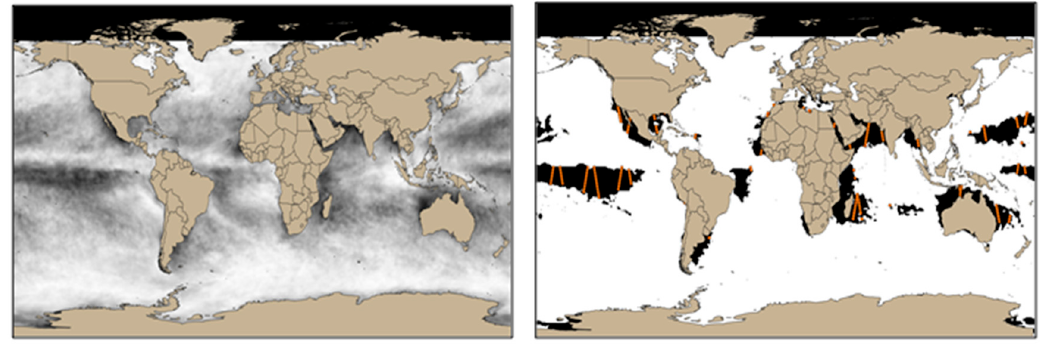
Figure 2. ( Left ) Temporal average of the MODIS monthly cloud product for November ( right ), and thresholded (50%) image of temporal average ( left ) with an orbital model overlaid for scene identi- fication.